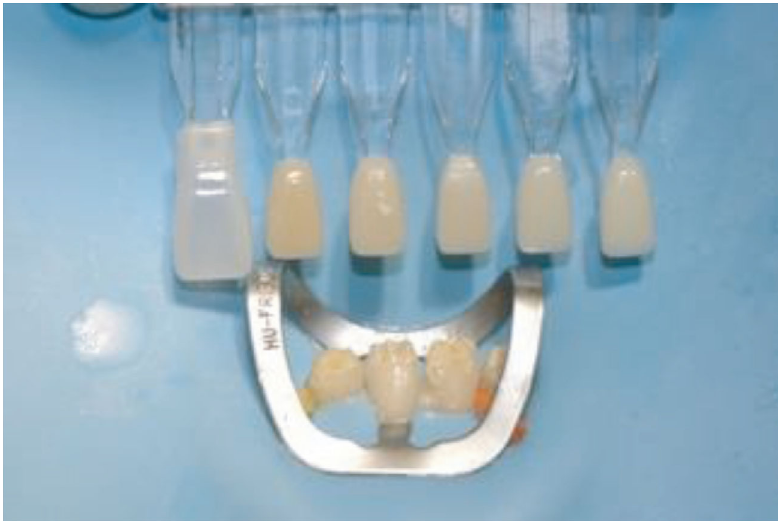
Figure 7: Shade selection of the luting composite using Edelweiss custom shade guide.